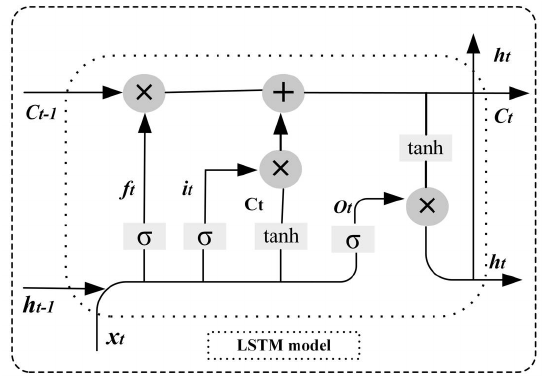
Figure 3. The structure of LSTM model.